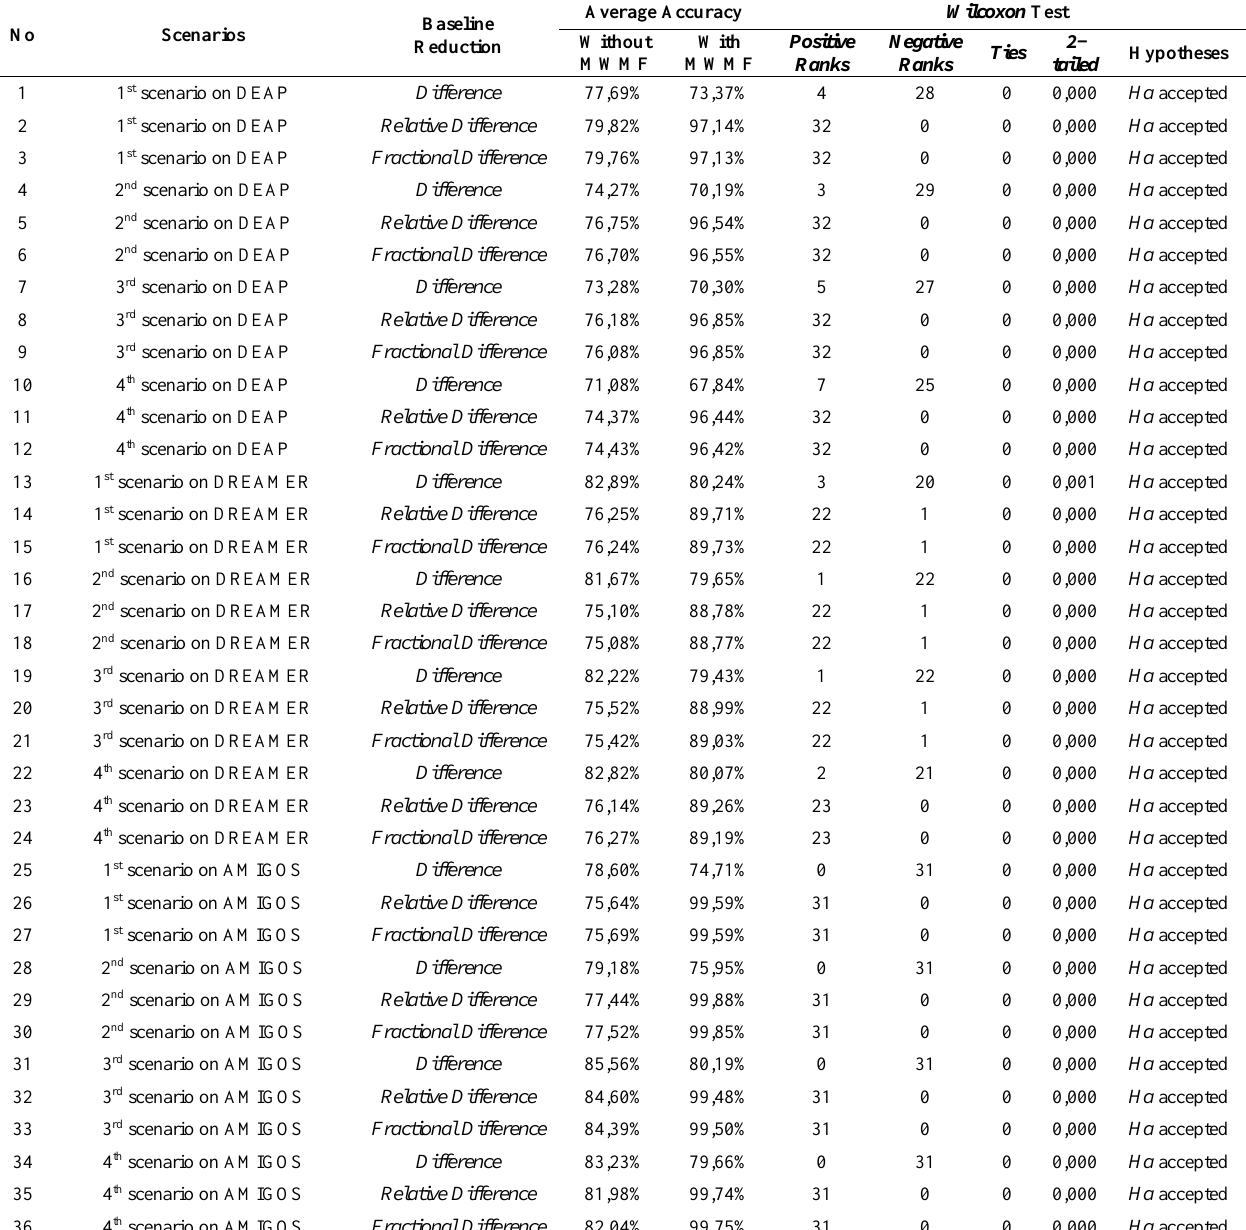
Table 8. Average accuracy and statistical test for each validation process on the DEAP, DREAMER, and AMIGOS